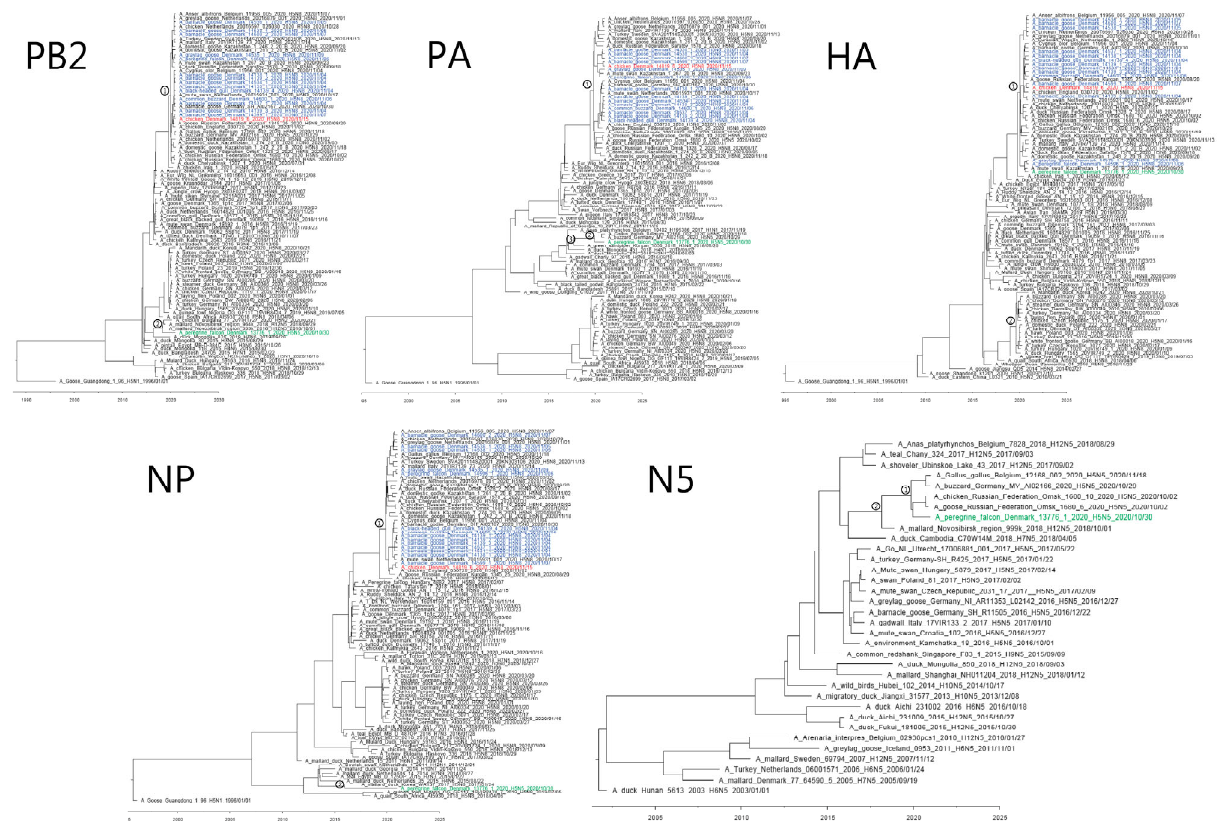
Figure 2. Maximum clade credibility trees of PB2, PA, HA, NP, and N5 gene segments from strict molecular clock analyses. The trees include gene segment sequences from Danish H5N8 and H5N5 viruses from 2020, representative Eurasian clade 2.3.4.4 HPAI H5 viruses and LPAI viruses. The numbers above the nodes represent time to most recent common ancestor (tMRCA). Tip labels are colored according to the background of the detections. Green: H5N5 wild bird virus; red: H5N8 virus from poultry; blue: H5N8 viruses from wild birds. The scale bar depicts the timeline. PB2, polymerase basic protein 2; PA, polymerase acidic protein; HA, hemagglutinin; NP, nucleoprotein; NA, neuraminidase.